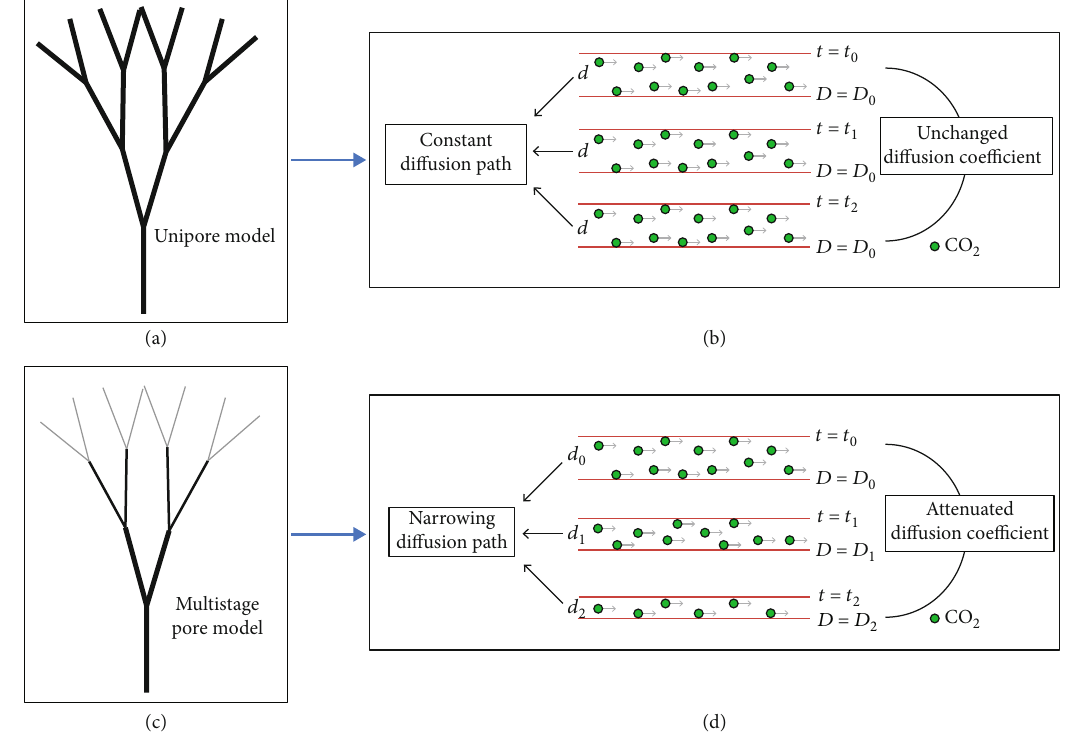
Figure 2: Two di ff erent models for CO